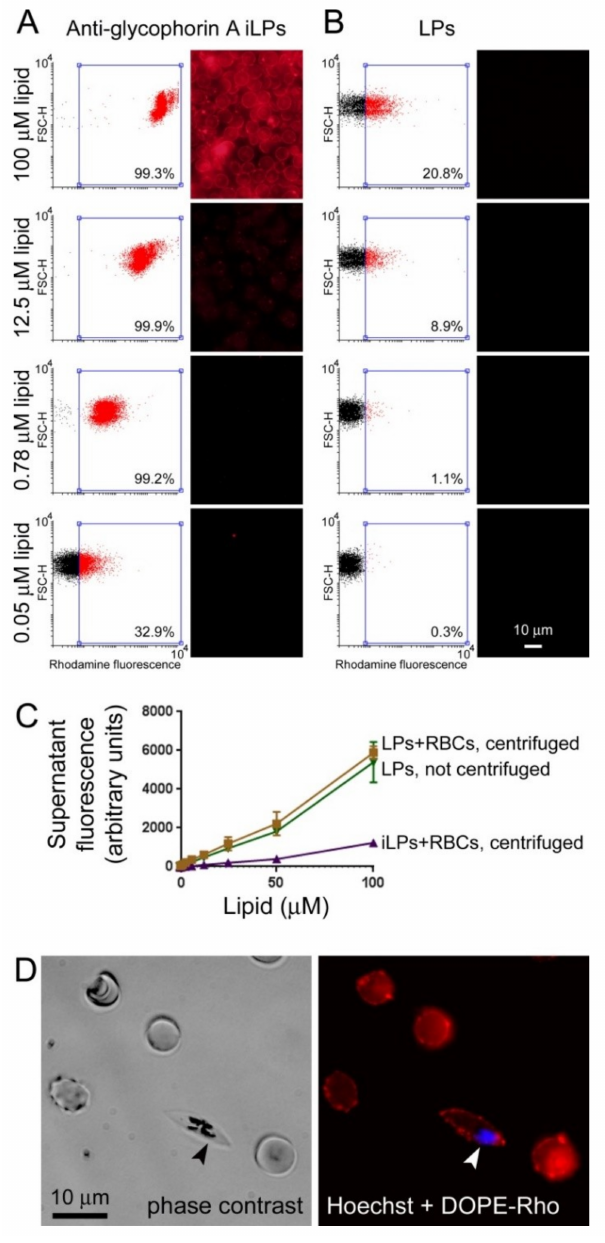
Figure 3. Immunoliposome targeting. ( A , B ) Flow cytometry and fluorescence microscopy RBC targeting analysis of DOPE-Rho-labeled ( A ) anti-glycophorin A iLPs and ( B ) plain liposomes at di ff erent (i)LP (expressed as lipid concentration):cell ratios. In each flow cytometry plot the fraction of targeted RBCs is indicated. The fluorescence microscopy settings were adjusted for a correct exposure of the 100 µ M lipid iLP sample. ( C ) Fluorescence analysis of the supernatants of centrifuged samples where DOPE-Rho LPs and iLPs had been preincubated with RBCs. ( D ) Fluorescence microscopy targeting analysis of the iLP sample to P. falciparum gametocytes. The arrowhead indicates a